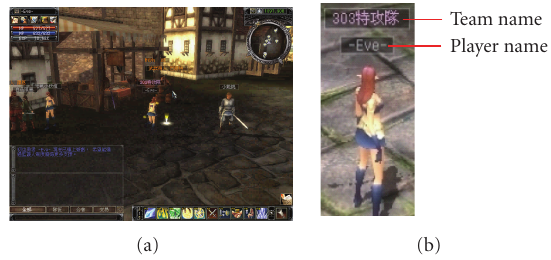
Figure 1: (a) A “day” in the world, (b) one of the people awareness tools.